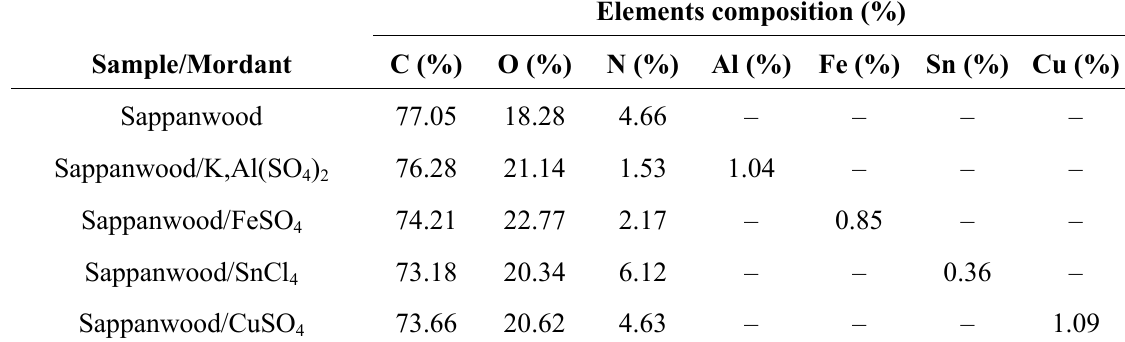
Table 3. XPS Surface compositions of silk fabric dyed with sappanwood extracts and different